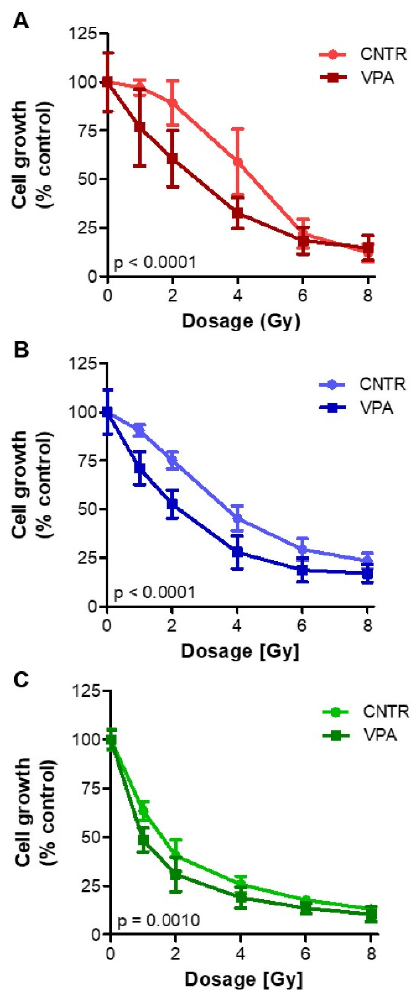
Figure 5. After a seven ‐ day treatment with the IC 50 dose, VPA ‐ treated and untreated BON ‐ 1 ( A ), NCI ‐ H727 ( B ), and GOT1 ( C ) cells were exposed to different dosages of irradiation using external beam radiation to investigate increased